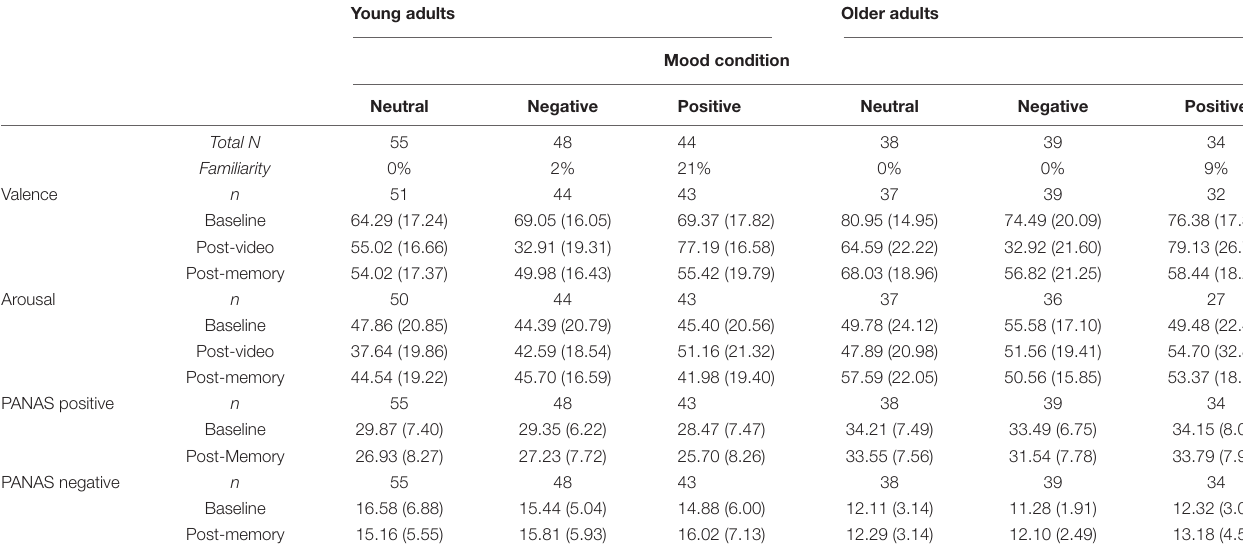
TABLE 4 | Mean (SD) self-reported valence, arousal, and positive and negative affect by age group and mood